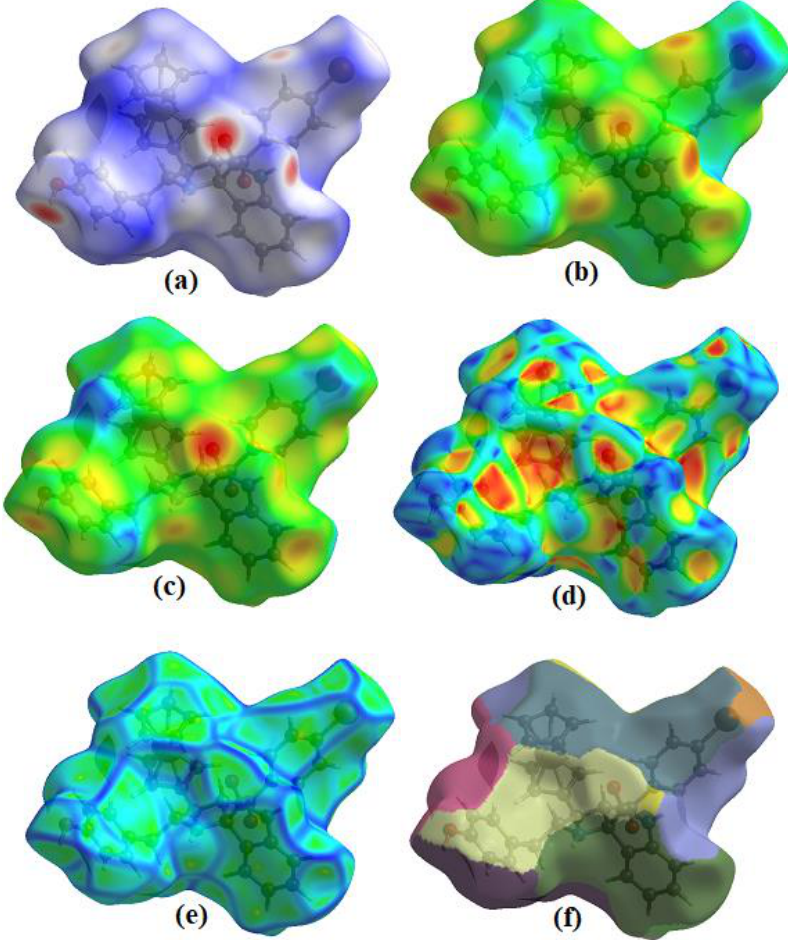
Figure 3. Hirshfeld maps for 3a mapped on ( a ) d norm , ( b ) d e , ( c ) d i , ( d ) shape index, ( e ) curvedness, and ( f ) fragment patch.